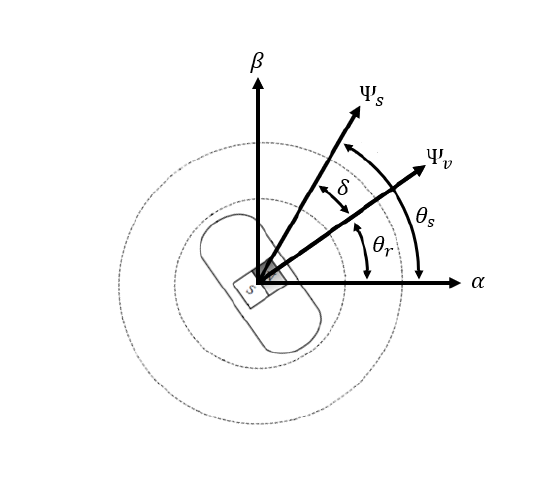
Figure 5. Difference between stator and rotor